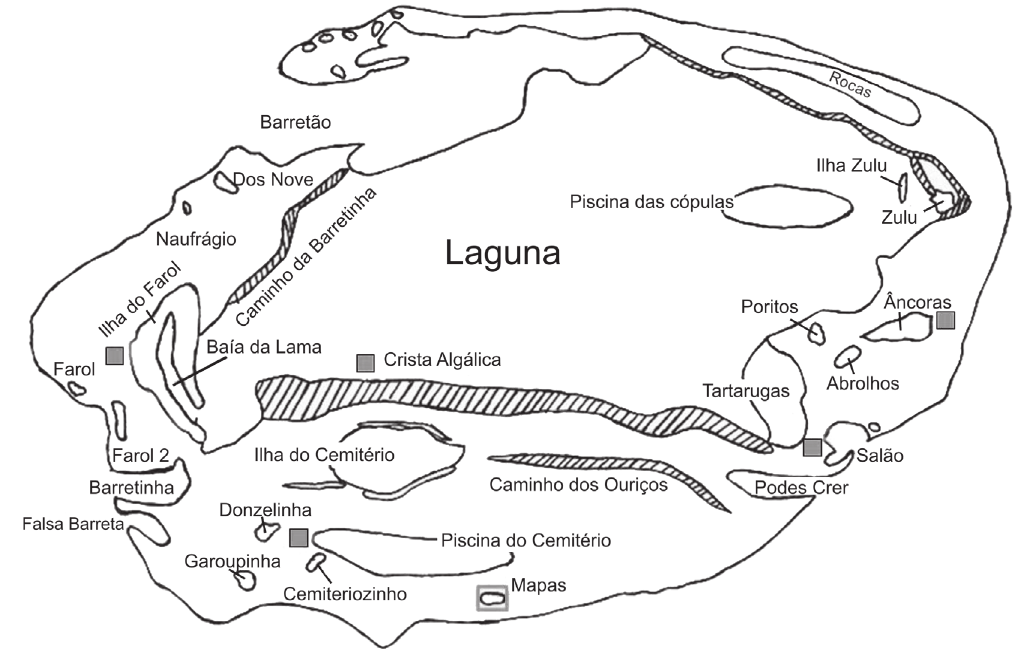
Figure 2. Map of the Atol das Rocas, with squares indicating the location of the sample areas.